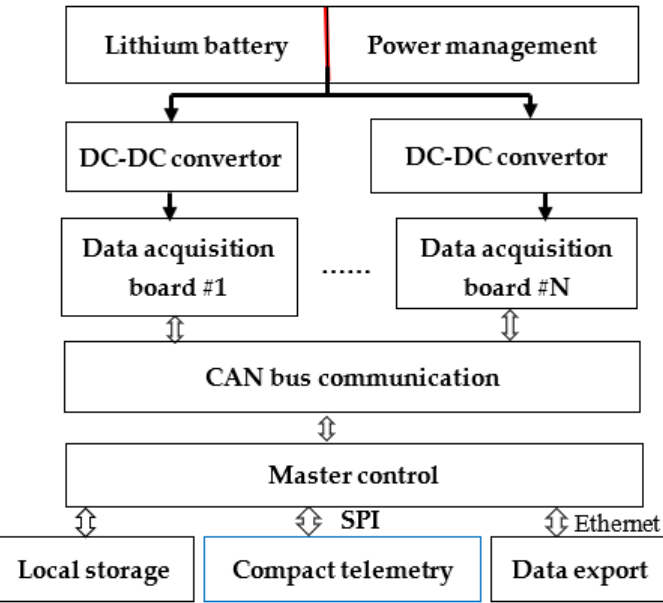
Figure 12. Schematic diagram of the borehole receiver.